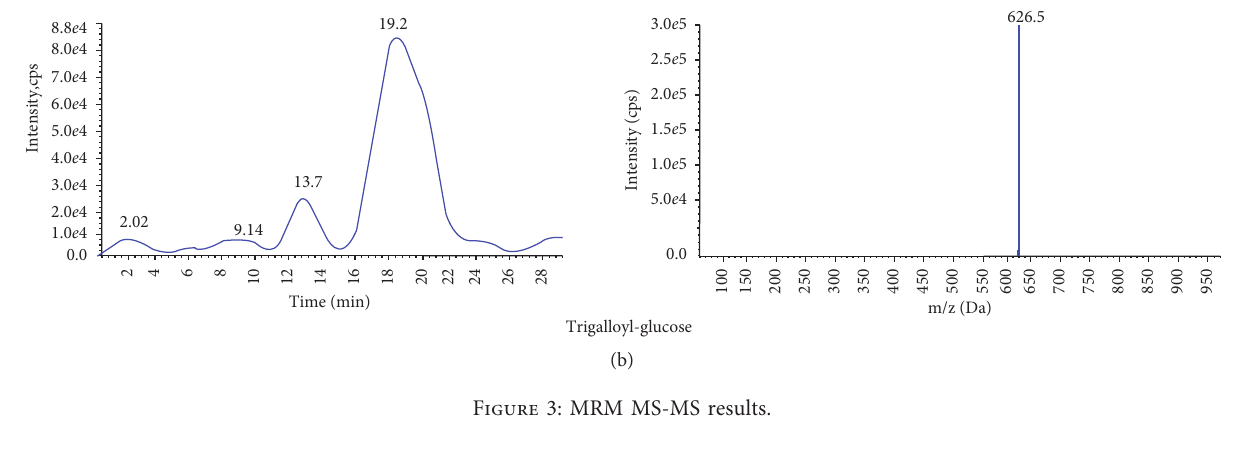
Figure 3: MRM MS-MS results.